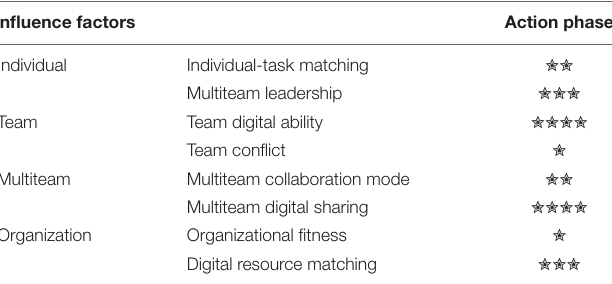
The number “ (cid:78) ” indicates the centrality ranking of the influencing factors. The more “ (cid:78) ” the higher the